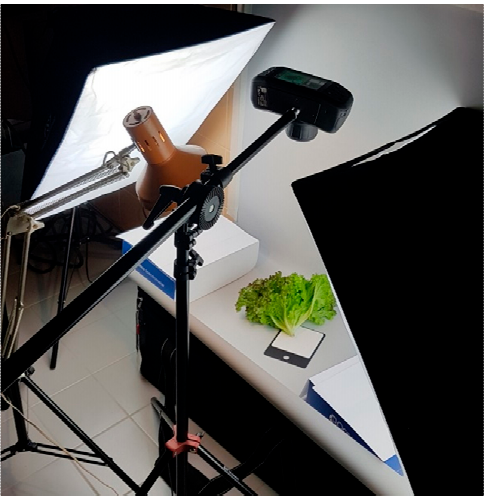
Figure 2. Hyperspectral recording of the fresh-cut lettuce leaves/plants with the SPECIM IQ camera (Spectral Images, Finland).